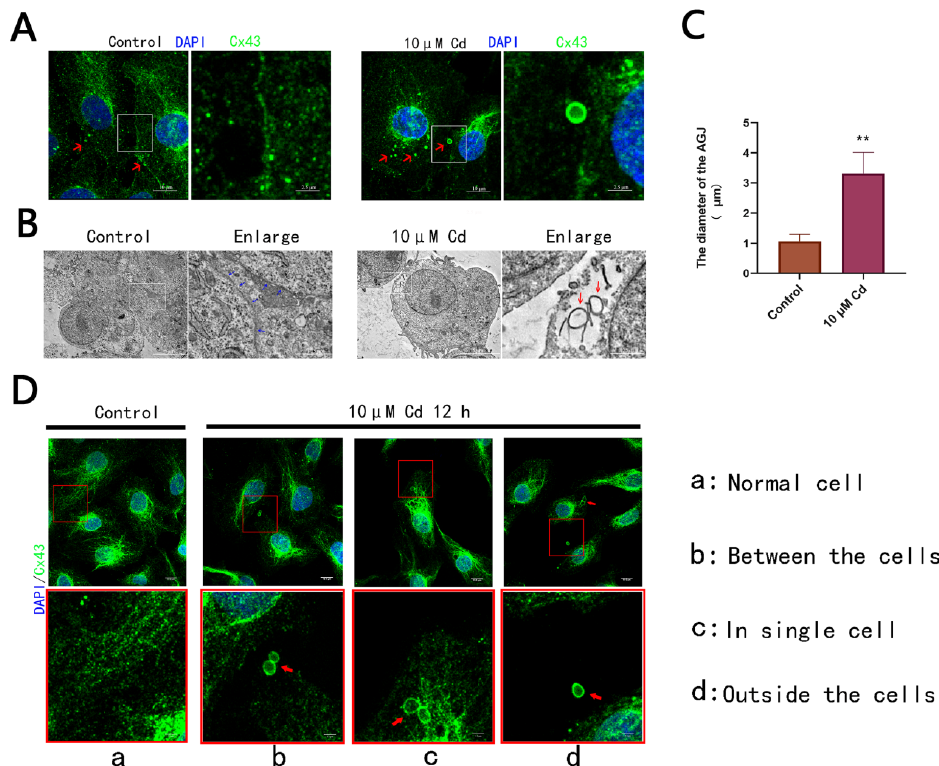
Figure 3. Cd induces the formation of AGJ in rat hepatocytes: ( A ) Cd exposure induced the formation of AGJs between cells in rat hepatocytes. Red arrows represent Cx43 spots or AGJs. Scale bar = 10 µ m; ( B ) AGJs observed under a transmission electron microscope. Blue arrows represent cell junction regions, and red arrows represent the AGJ of the bilayer membrane. Scale bar = 5 µ m; ( C ) Image J software was used to determine the diameters of AGJ and normal Cx43 spots and eventually calculate the ratio. This method is a way to manually count the particle diameter in images provided by Image J software: set a ruler for images, and then manually measure the diameter of Cx43 fluorescent sites (13 in total, 1 fluorescent site per cell) in cells of the control group and the diameter of all AGJ (13 in total) in cells of Cd group, and then use GraphPad Prism software to compare the difference between two groups of data. The results were derived from measuring the diameters of 13 different AGJs. ** p < 0.01 compared to the control group; ( D ) Cd exposure induced the formation of AGJs in different regions of rat hepatocytes. Red arrows represent the structure of AGJ. Scale bar = 10 µ